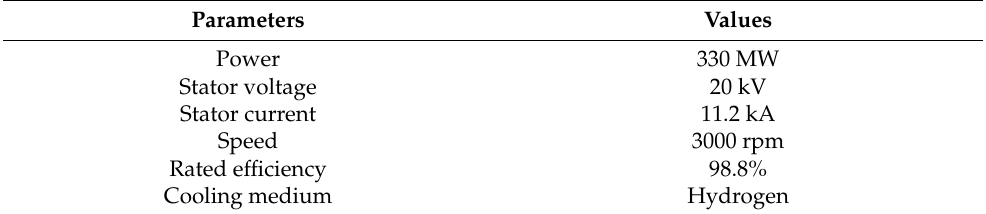
Table 1. Basic parameters.